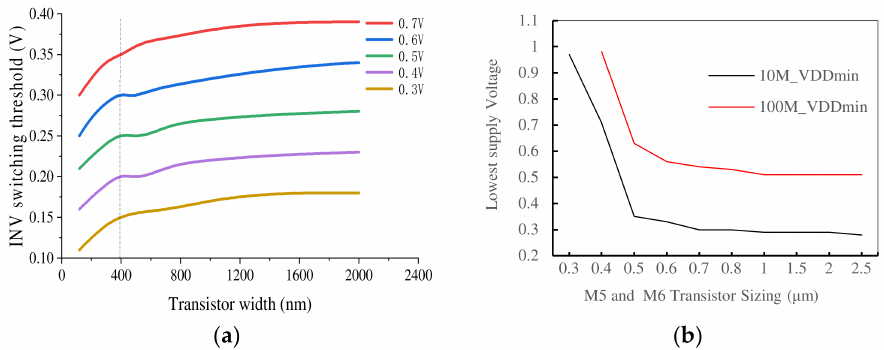
Figure 5. ( a ) V T of the inverter with different PMOS transistor sizing. ( b ) The lowest operating voltage of the NTSD with different sizing of M5 and